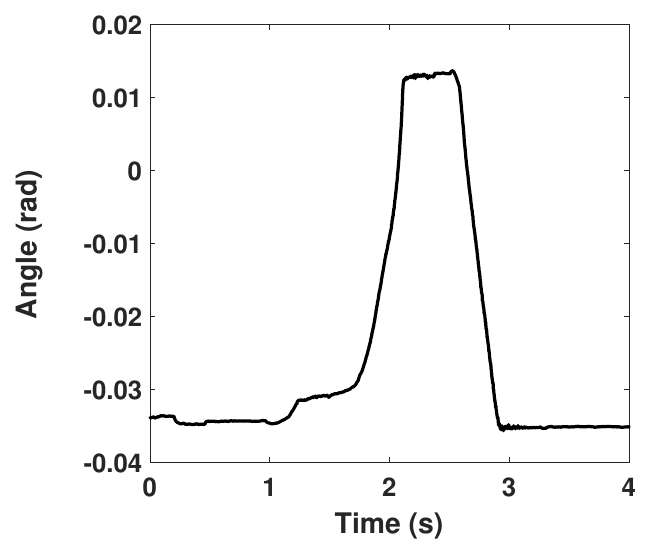
Figure 19. Key position applied for the validation with piano action model.